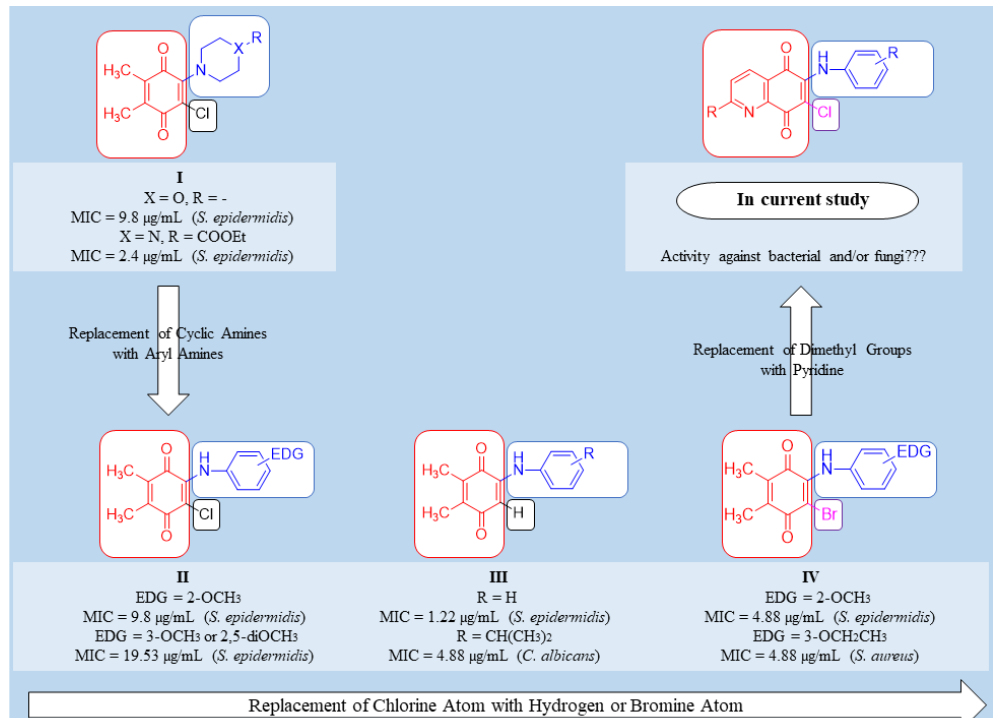
Figure 2. Important aminoquinones employing different groups within 1,4-quinone moiety as a side group possesses interesting biological activities.